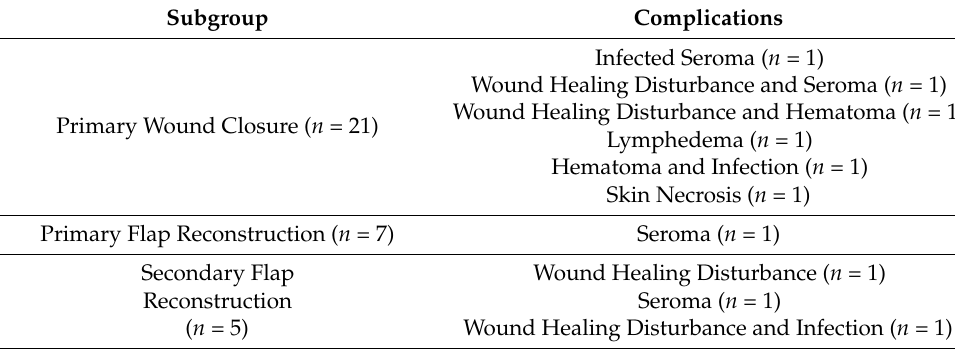
Table 3. Complications after surgical therapy of extremity